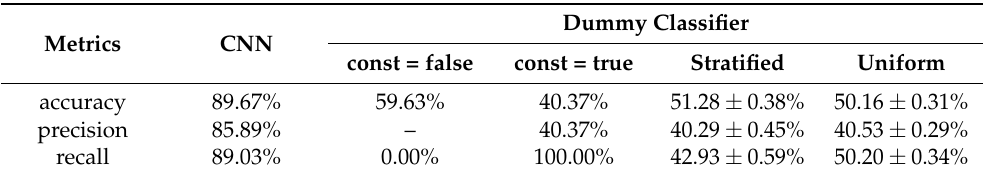
Table 5. Performance comparison between CNN-based and Scikit Dummy Classifier detectors for a screen recapture per-frame detection task.